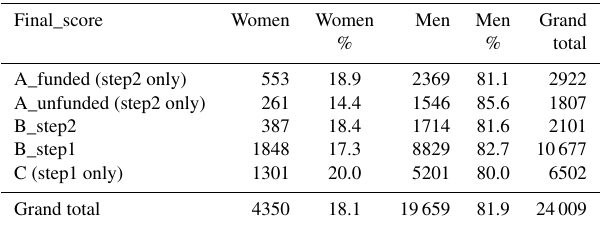
Figure 2. Number of applications for women and men per country for the ERC PE panels 2012–2018 in countries with at least 50 ap- plicants during that period.